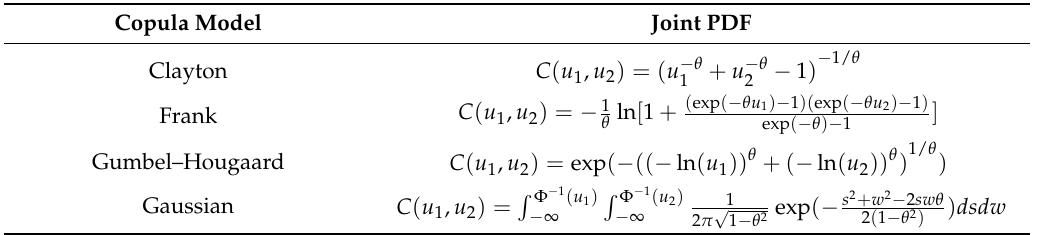
Table 1. Joint PDF of copula models considered in this study.